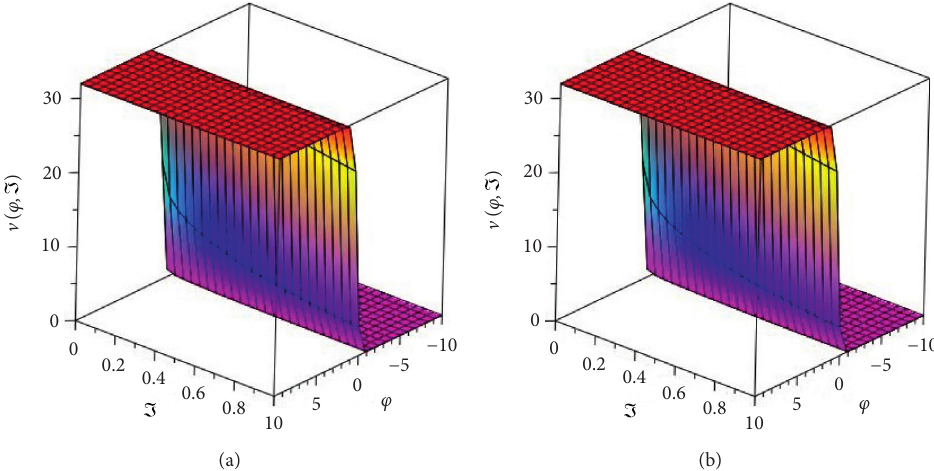
Figure 6: The exact and analytical solution with respect to the Atangana–Baleanu operator of ] ( φ , I ) at β � 1 of Example